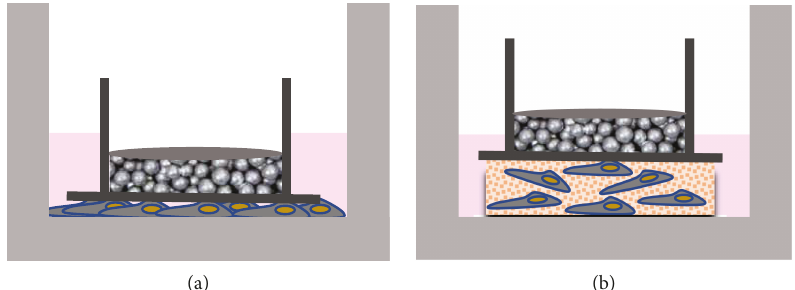
Figure 2: Schematic illustration of the static 2D (a) and 3D (b) in vitro loading model based on the weight approach applied in the literature (details are found in the